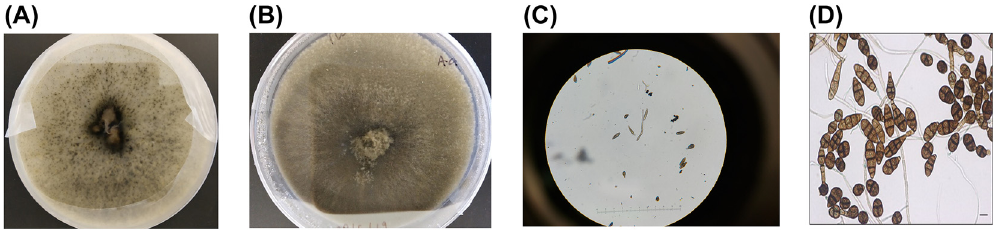
Figure 2: Cultural and morphological characteristics of Alternaria sp. (A) lower side view of the growth of the pathogen in Petri plates, (B) upper side view of the growth of the pathogen in Petri plates, (C) and (D) microscopic view of the spores of the fungus identi fi ed as Alternaria alternata.